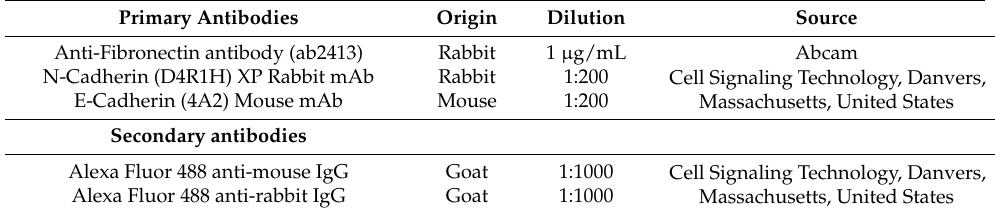
Table 2. List of antibodies for immunofluorescence